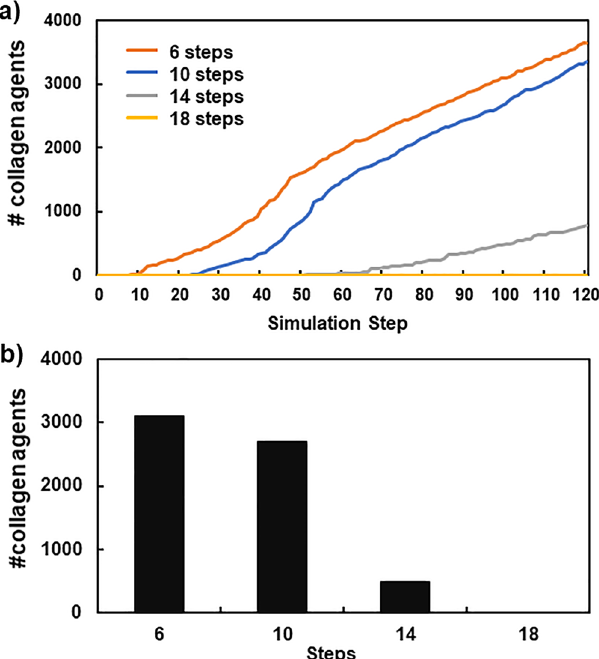
Figure 4. Relationship between the interval of toxic compound injection and the number of produced collagen agents. X and Y-axes indicate the time (step) and collagen amount, respectively ( a ). X and Y-axes indicate the interval and the number of collagen agents, respectively ( b